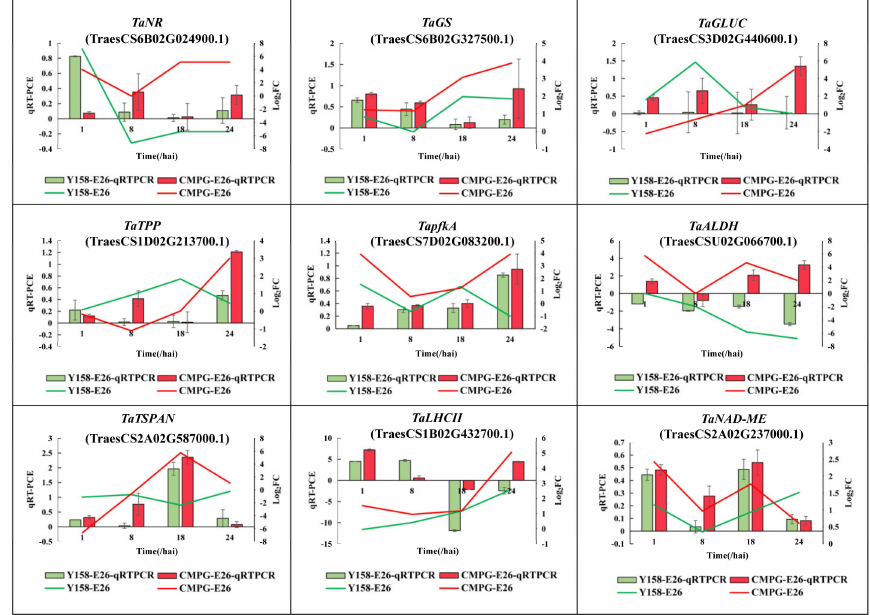
Figure 7. qRT-PCR and sequencing data of genes expression in CMPG1-V OE and susceptible receptor Yangmai 158 from 1 hai to 24 hai after Bgt infection. The histogram represents qRT-PCR of gene expression. Green represents Yangmai 158, red represents CMPG1-V OE . Line chart represents sequencing data of genes expression. The green line represents Yangmai 158, red line represents CMPG1-V OE